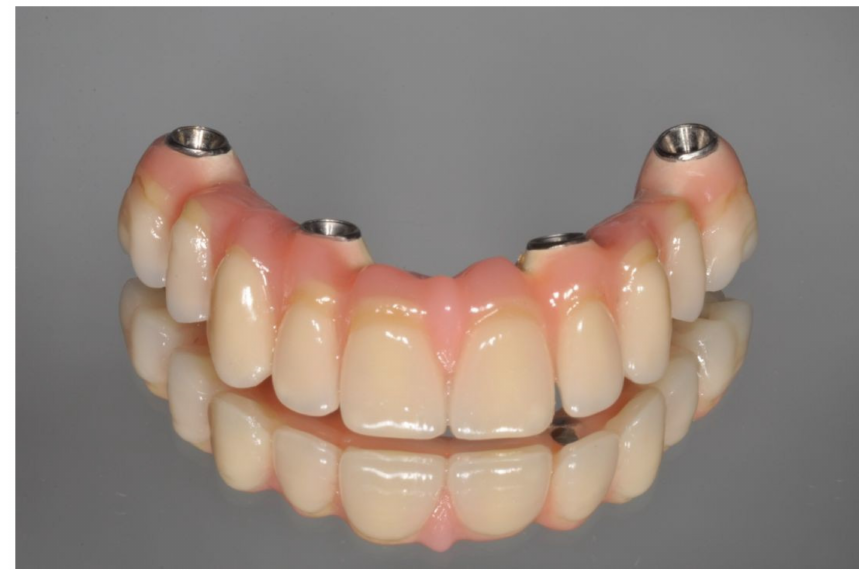
Figure 4. Interim prosthesis without